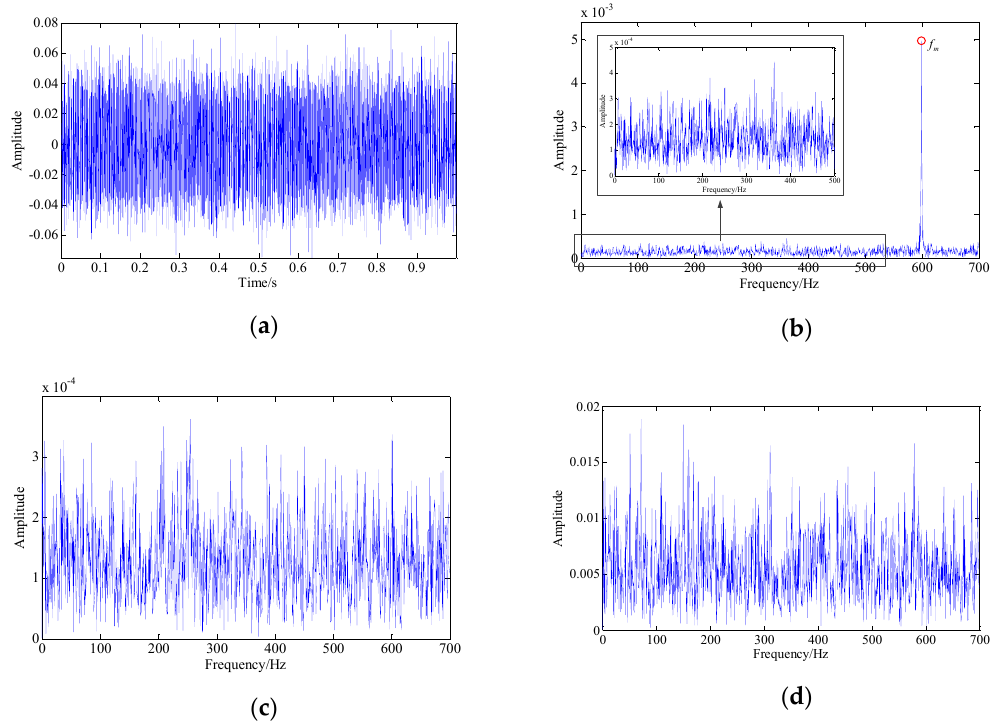
Figure 4. The mixed signal consists of the signal shown in Figure 3 and white Gaussian noise (signal-to-noise ratio (SNR) = -10 db): ( a , b ) the waveform and spectrum of the mixed signal; ( c,d ) the envelope spectrum and instantaneous frequency spectrum of the mixed signal.